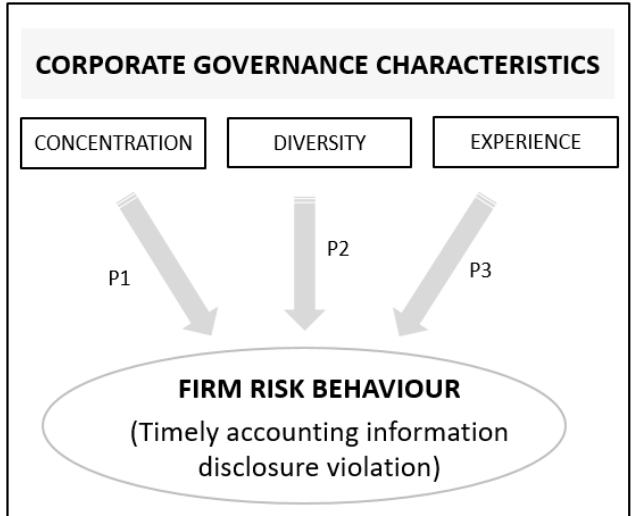
Figure 1. Conceptual framework of the study. Source: Own elaboration.